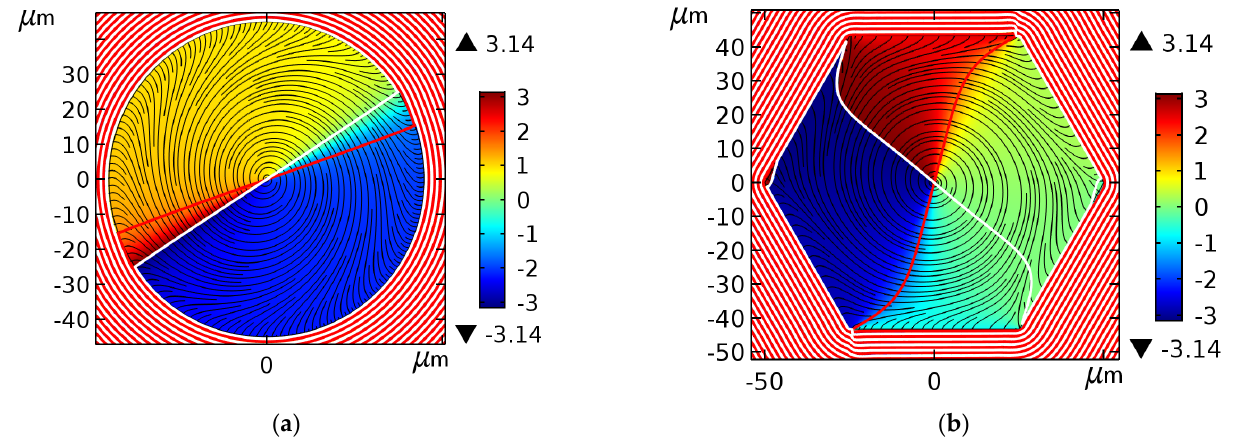
Figure 3. Phase distributions of the axial components of electric fields E z for the air core waveguides shown in Figure 2: ( a ) the air hole in the infinite layer of a dielectric; ( b ) hollow core hexagon in the infinite layer of a dielectric. Thin red and white lines correspond to the condition that the real (red) and imaginary (white) parts of the axial component of electric field being equal to zero. The phase changes from −π (dark blue) to π (dark red).